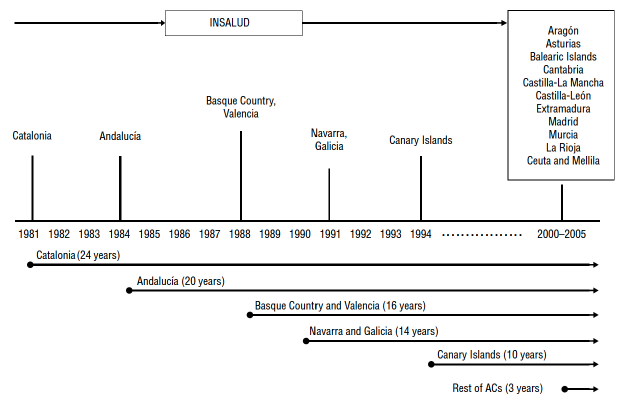
Figure 1. Chronology of devolution of health competences to autonomous regions in Spain. * Source: Ministry of Health and Consumer Affairs